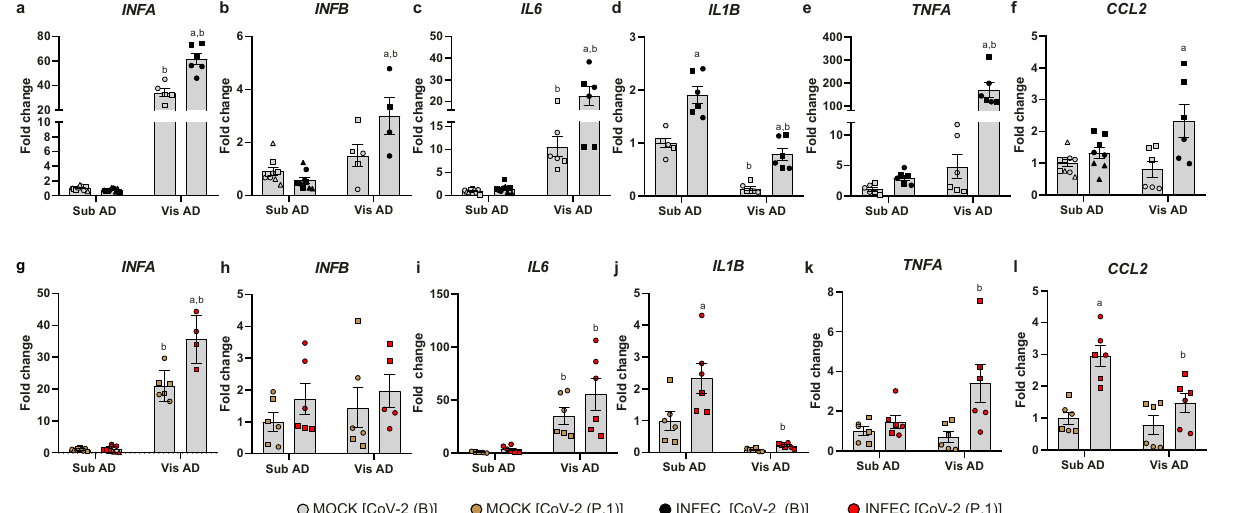
Fig. 5 | Genes associated with in fl ammation are differentially expressed in SARS-CoV-2-infected adipose tissuecells.a – l Stromal-vascularcellsfrom human subcutaneous and visceral fat depots were differentiated into adipocytes (Sub AD and VisAD,respectively)and infected (INFEC)ornot (MOCK)with theSARS-CoV-2 ancientstrain[CoV-2(B)]( a – f )ortheP.1variant[CoV-2(P.1)]( g – l ).Geneexpression as quanti fi ed by RT-qPCR 24h post-infection. Two-way ANOVA with Tukey ’ s mul- tiple comparison test was applied to identify differences between groups. These differences are depicted in letters: a, P <0.05 vs. respective MOCK; b, P <0.05 vs.